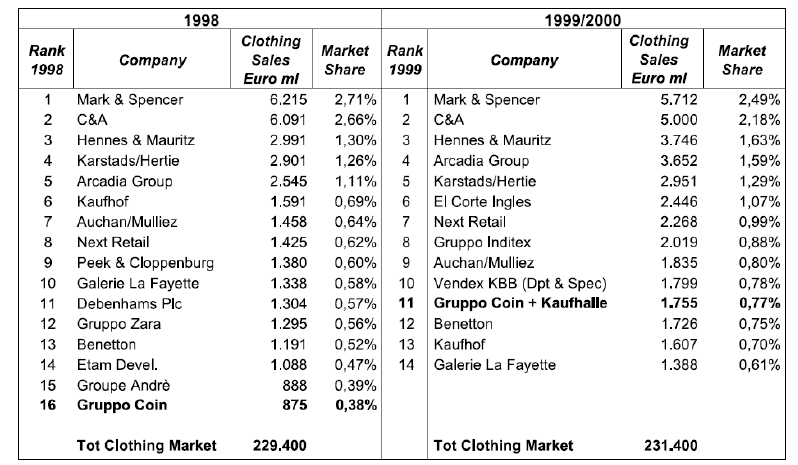
Table 1: European Market